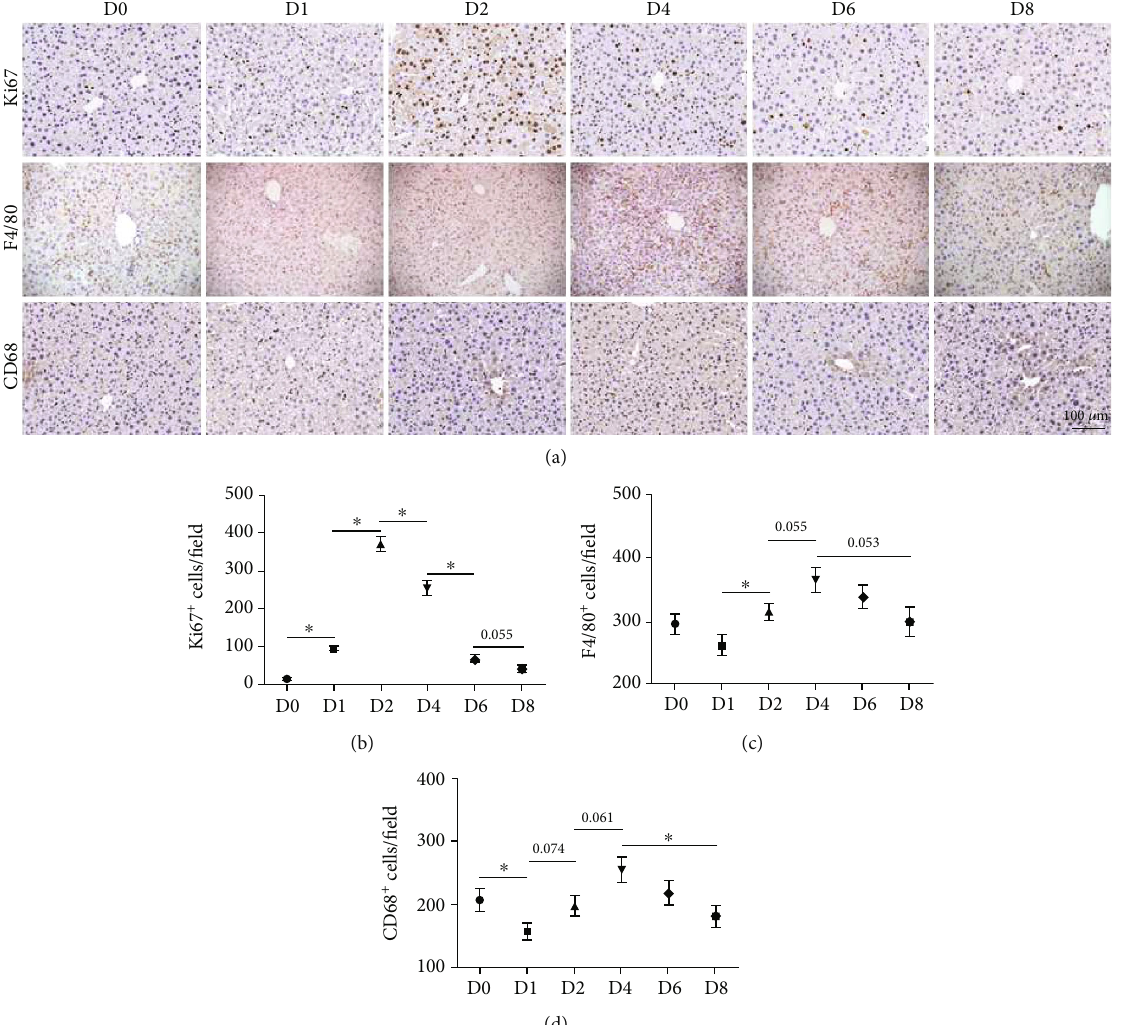
Figure 1: The dynamic change of the number of macrophage subsets after PHx. (a) C57BL/6 mice were sacri fi ced at day 1, 2, 4, 6, or 8 after 2/3 PHx or sacri fi ced immediately after sham operation. Liver sections were stained with anti-Ki67, anti-F4/80, or anti-CD68 IHC. The brown grains indicated the positively stained regions. The number of (b) Ki67 + cells, (c) F4/80 + cells, and (d) CD68 + cells in (a) were counted and quantitatively compared. Bars = means ± SD , n = 8 . ∗ P < 0 : 05